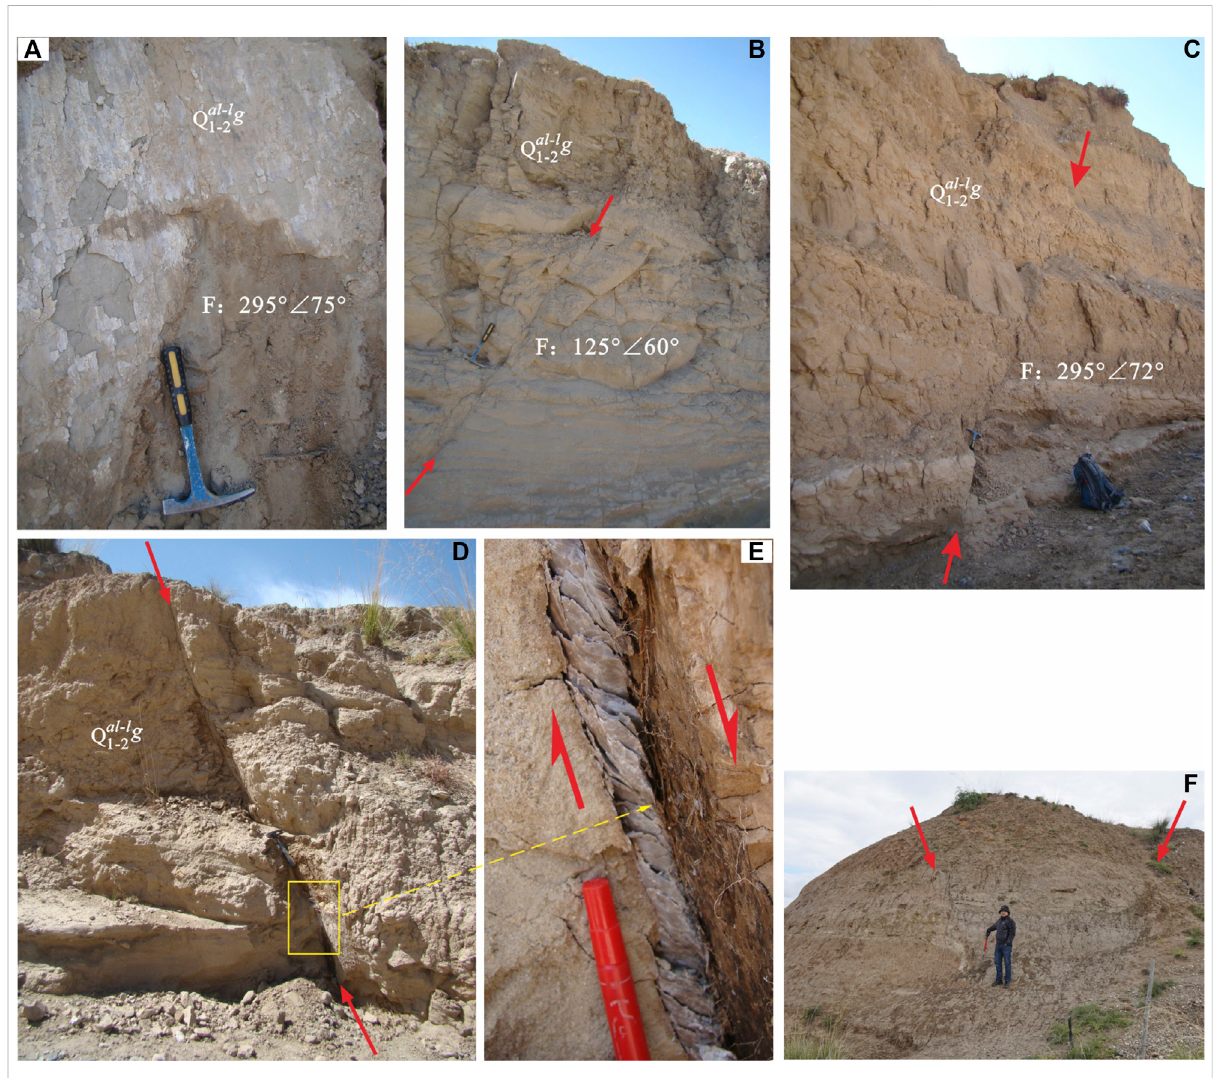
FIGURE 8 NS-trending normal faults along Ayihai gully. (A,B) Normal faults in northern Ayihai Valley. (C,D,E) Normal faults and S-shaped shear joints in central Ayihai Valley. (F) Combination of graben normal faults north of Dejilicun in southern Ayihai